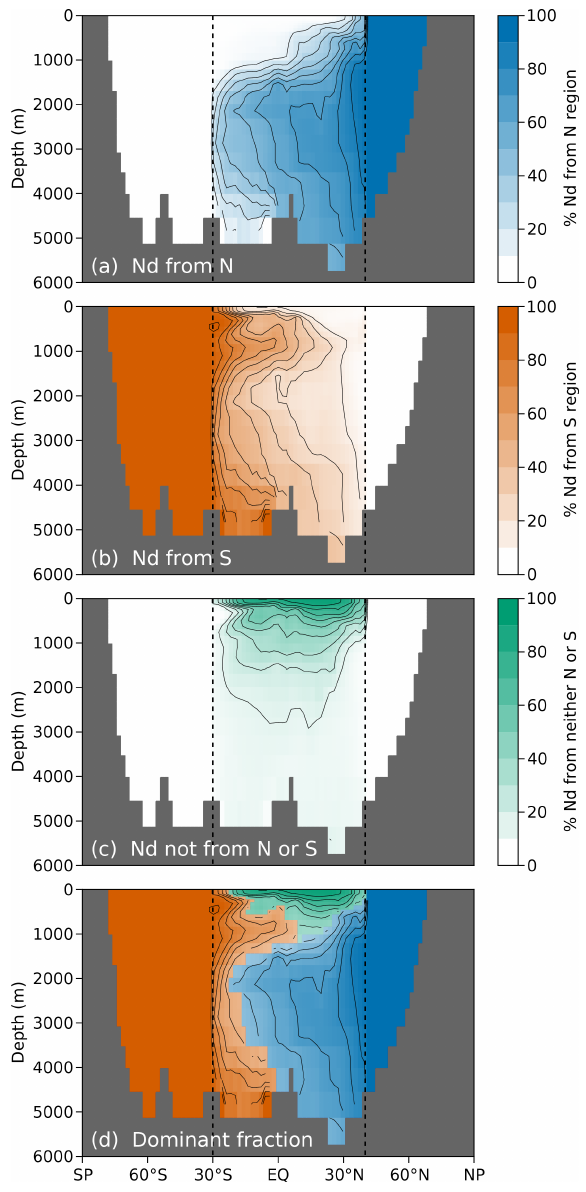
Figure 13. (a) Atlantic zonal average of the fraction of Nd tagged in the (cid:127) N region (north of 40 ◦ N; blue). (b) Same for Nd tagged in the (cid:127) S region (south of 30 ◦ S; orange). (c) Same for Nd tagged injected within the midlatitude Atlantic (between 30 ◦ S and 40 ◦ N; green). (d) Atlantic zonal average showing only the dominant frac- tion of Nd coming from either (cid:127) N or (cid:127) S or from within 30 ◦ S– 40 ◦ N. Contour lines are shown for each 10% increment. Tagging regions are shown in Fig. 12.